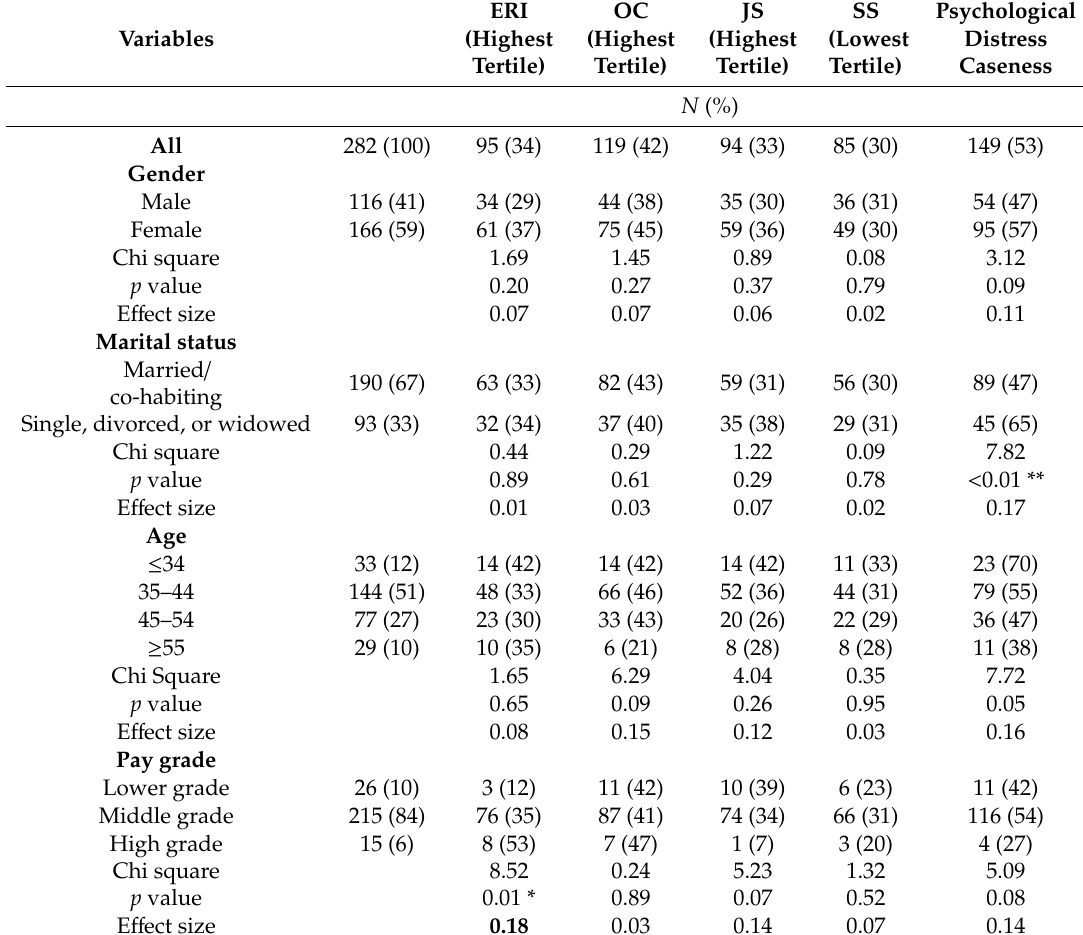
Table 1. Associations between demographic variables, psychological distress, and the highest risk tertiles of work-related stress variables.